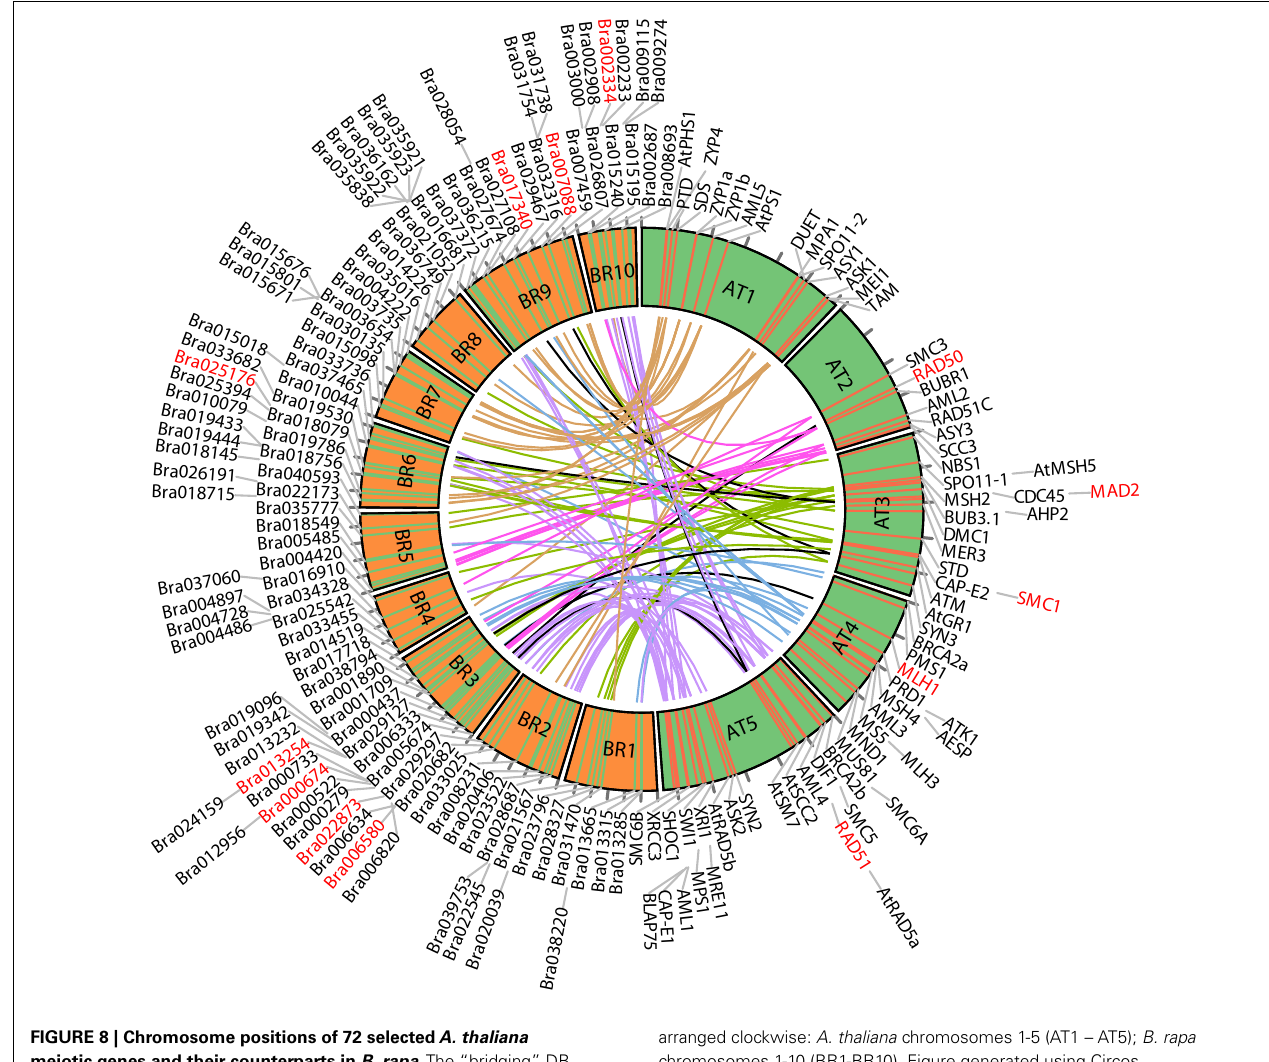
FIGURE 8 | Chromosome positions of 72 selected A. thaliana meiotic genes and their counterparts in B. rapa . The “bridging” DB represents possible collinearity and gene duplications. Genomes are